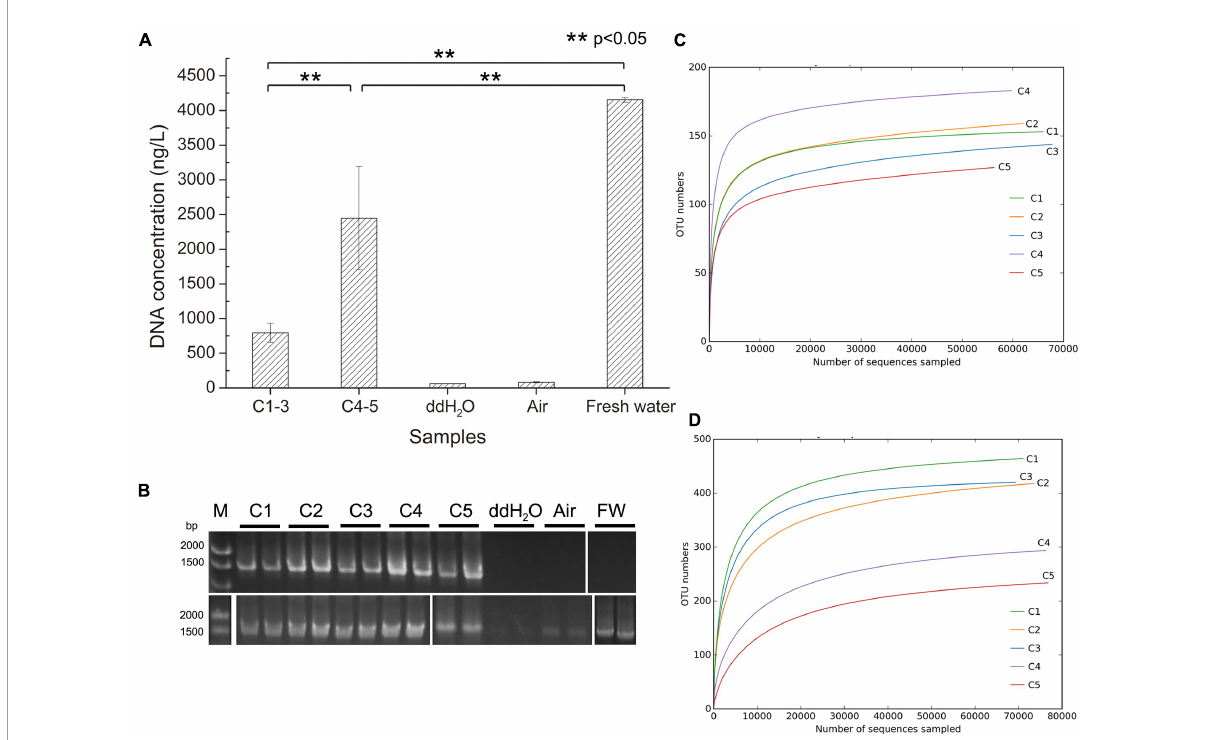
FIGURE2 Total environmental DNA extraction and 16S RNA amplicon sequencing rarefaction curves. (A) The total DNA was extracted from 1 L of the corresponding samples except from the air in the lab with suction filtration approach. C1-3, three brine samples (C1, C2, and C3) collected in July 2021; C4-5, two brine samples (C4 and C5) collected in August 2018; ddH 2 O, distilled water; Air, time duration of lab air suction filtration was the same as ddH 2 O; Fresh water, the natural water source used to dissolve salt mines for brine production. ** p < 0.05, significant difference. (B) These extracted environmental DNA was used as PCR template for amplifying haloarchaeal (upper row) and bacterial (bottom row) 16S rRNA gene using F8/R1462 and 27F/1492R, respectively. FW, fresh water; DNA ladder was shown on the left. (C) Rarefaction curve